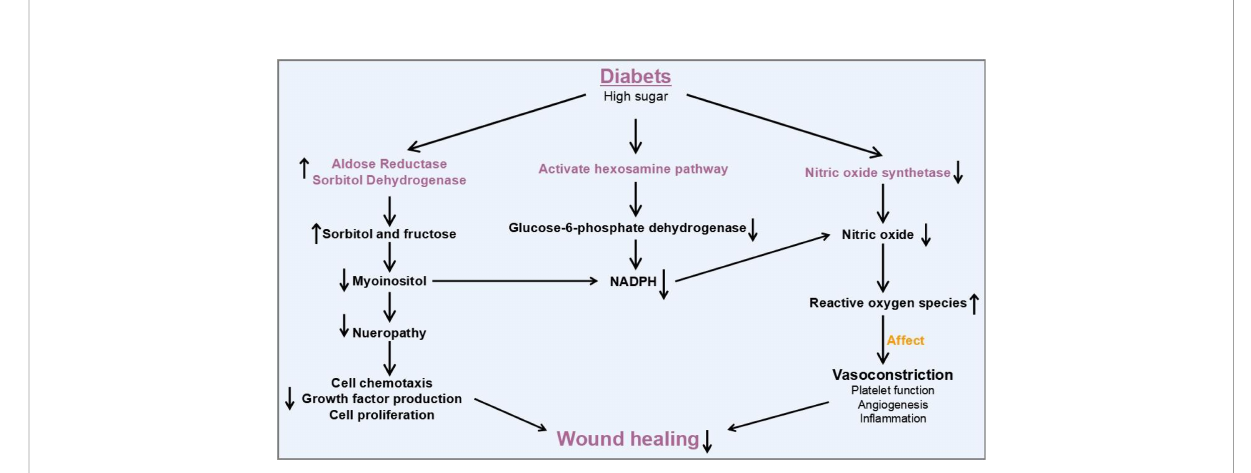
FIGURE 1 Molecular mechanisms and therapeutic potential of exosomal ncRNAs involved in diabetic wound